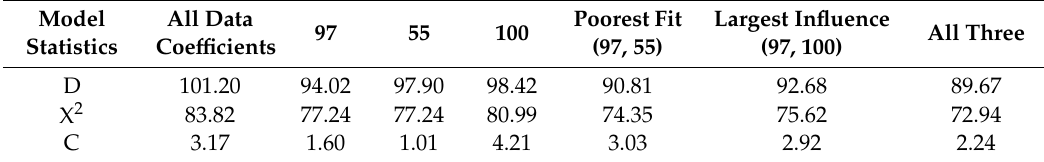
Table 7. Model statistics for the original model and six